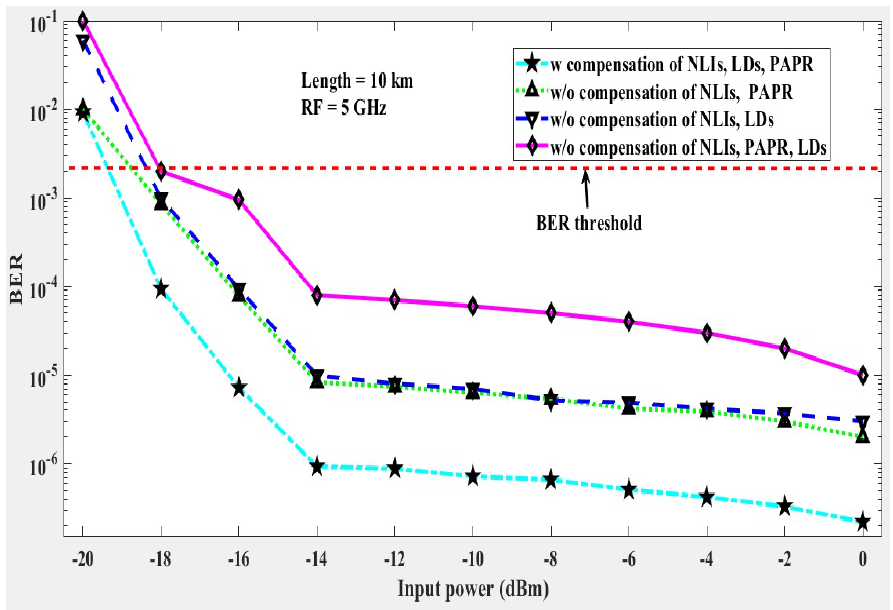
Figure 8. BER versus input launch power at 10 km optical fiber length for evaluating nonlinear impairments (NLIs), peak to average power ratio (PAPR) and linear distortions (LDs).